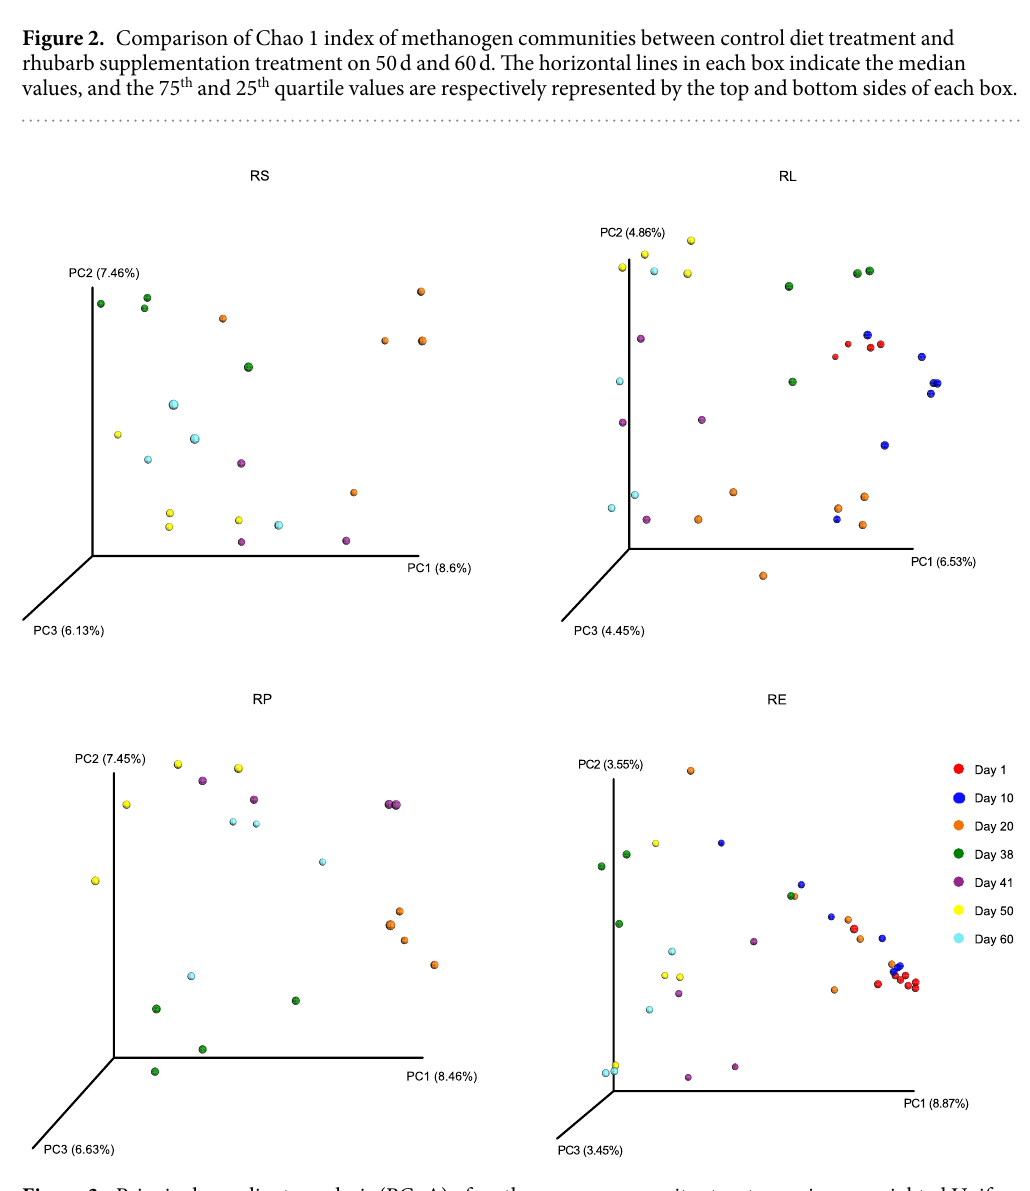
Figure 3. Principal coordinate analysis (PCoA) of methanogen community structure using unweighted Unifrac matrix within different ages for each